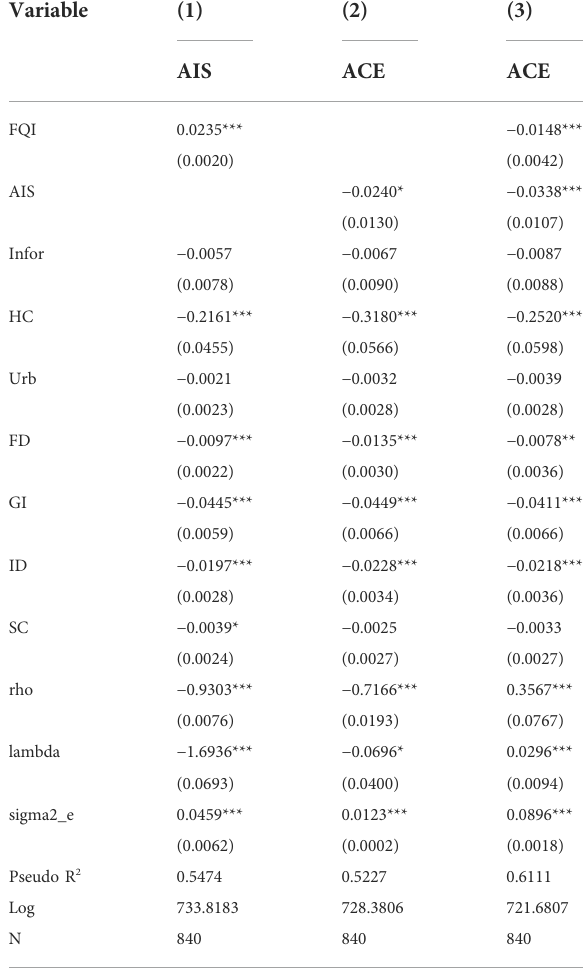
TABLE 8 Results of mechanism